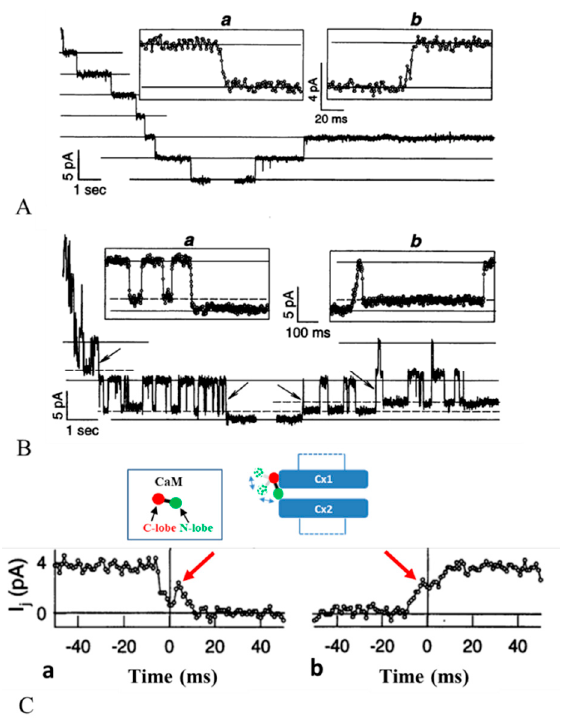
Figure 10. Effects of 100% CO 2 on single-channel gating behavior in gap junctions of fibroblast pairs subjected to Vj 30 ( A ) or 55 ( B ) mV. Gating was monitored before total uncoupling (A and B, left traces) and at the initial recoupling phase ( A and B , right traces). With Vj = 30 mV ( A ), each channel closes by a slow Ij transition from open, yj(main state), to closed state ( A , left trace and inset a ) and reopens with a slow transition from closed state to yj(main state)( A , right trace and inset b ). With Vj = 55 mV ( B ), the channels show two Ij transition: (1) between open and closed state (120 pS, ~10 ms; B , left trace, arrows and inset a ), and (2) between open and residual state (90 pS, 2 ms; B , left trace and inset a ). The channels reopen by a slow Ij transition to open state ( B , right trace, arrows and inset b ), followed by fast flickering to residual state. Thus, the chemical gate closes slowly and completely, while the fast Vj gate closes fast and partially. Chemical gate transitions between open and fully closed states ( C , a ) and vice versa ( C , b ), often display fluctuations ( C , red arrows), suggesting that the gate (CaM’s N-lobe?) may flicker in and out of the channel’s mouth before settling ( C , inset). From [79].